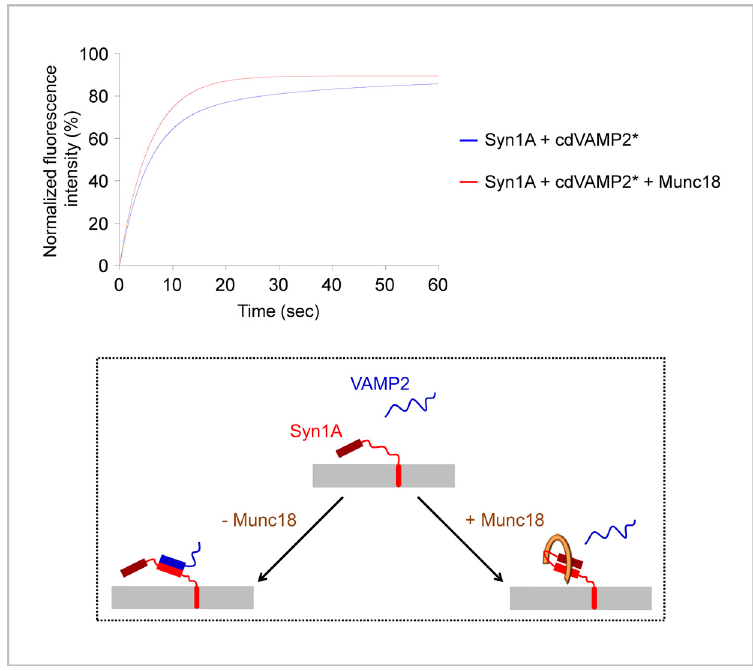
Fig 5. Interaction between SNARE proteins in a sponge phase. The full length Syn1A protein and the cytoplasmic domain of FITC-labeled VAMP2 protein (cdVAMP2 * ) were reconstituted into two separate sponge phases (at the respective lipid-to-protein molar ratios of 20,000 and 80,000). The Syn1A sponge was pre-incubated for 1 hour at room temperature with or without Munc18-1 protein (1:1 molar ratio between Syn1A and Munc18-1). The Syn1A ± Munc18-1 sponge and the cdVAMP2 * sponge were then mixed and allowed to interact for 1 hour at room temperature. In the absence of Munc18-1 (blue fitting curve), cdVAMP2 * displays two diffusion coefficients: a slow diffusion coefficient (2.0 ± 0.1 μ m 2 /s) corresponding to cdVAMP2 * bound to Syn1A in the sponge membrane and a fast diffusion coefficient (9.7 ± 1.4 μ m 2 /s) corresponding to free (unbound) cdVAMP2 * in the sponge channels. In the presence of Munc18-1 (red fitting curve), cdVAMP2 * displays a single, fast, diffusion coefficient (6.4 ± 1.1 μ m 2 /s), as observed when it is added to a protein-free sponge phase, showing that Munc18-1 inhibits the interaction between Syn1A and cdVAMP2 * (see also Table